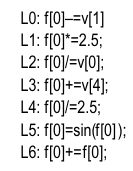
Fig. 4. An excerpt of a linear genetic